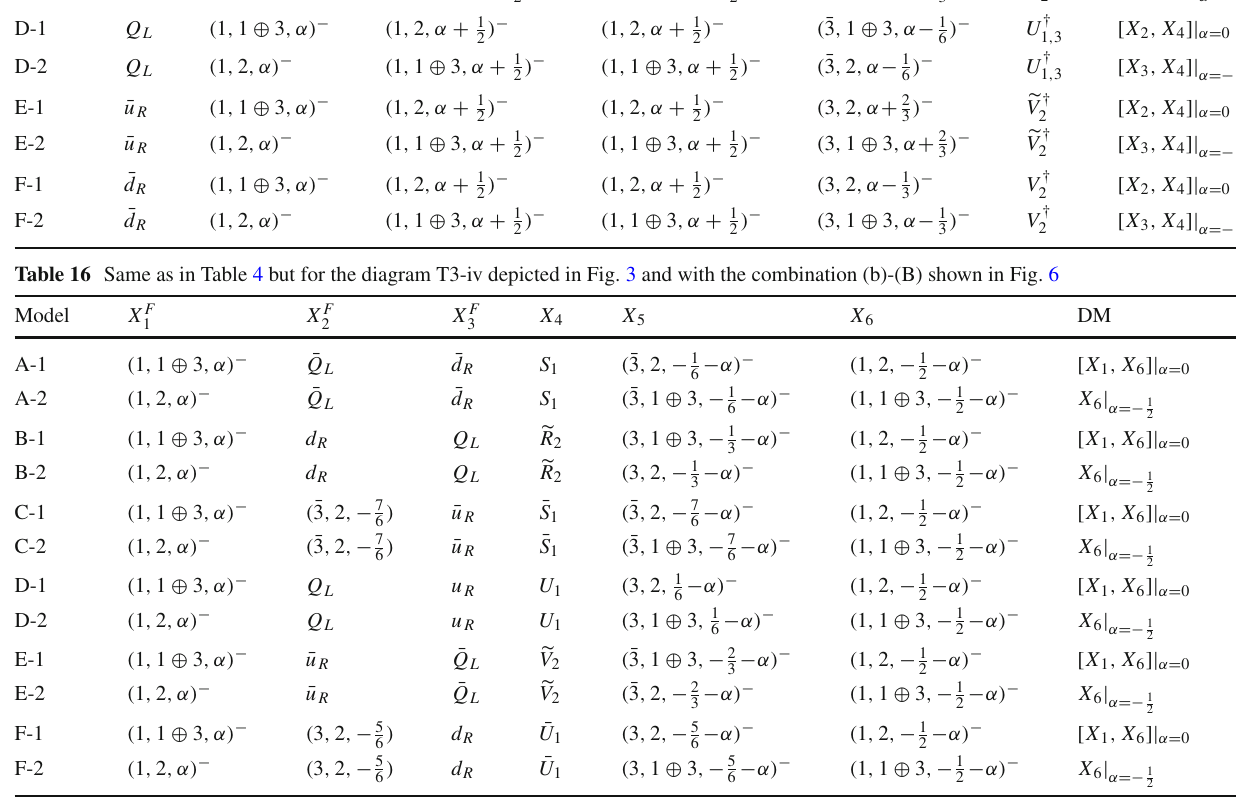
Table 17 Same as in Table 4 but for the diagram T3-x depicted in Fig. 3 and with the combination (a)-(A) shown in Fig. 6